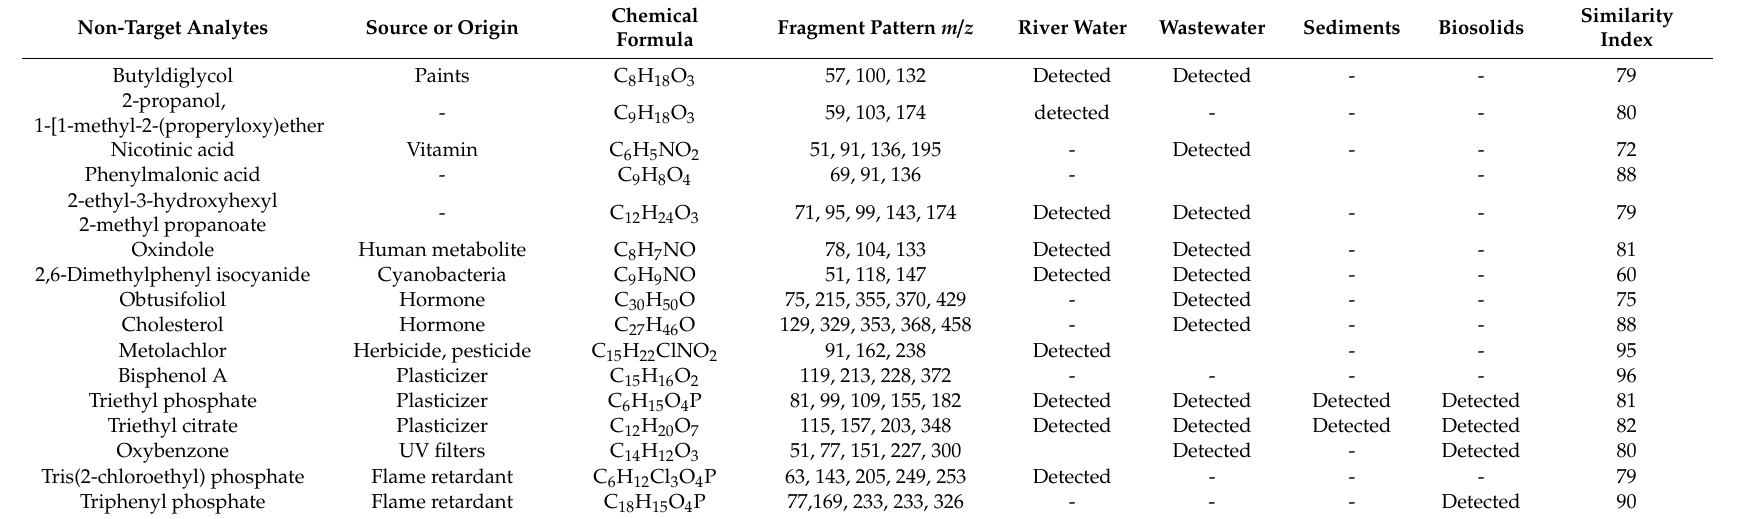
Table 7. Non-target analysis of new emerging contaminants in the Msunduzi and Mgeni River at Schymansaki assessment level